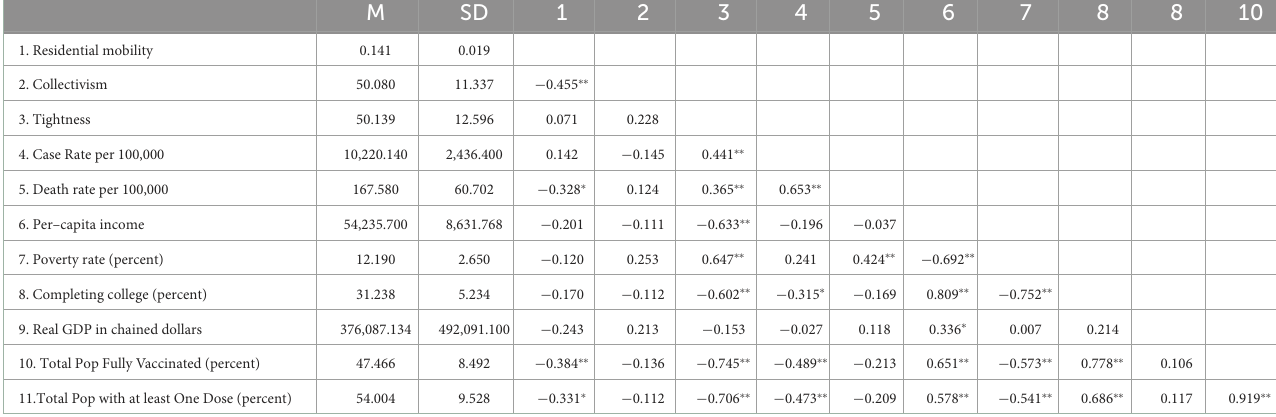
TABLE 1 Descriptive statistics and bivariate correlations of main variables.